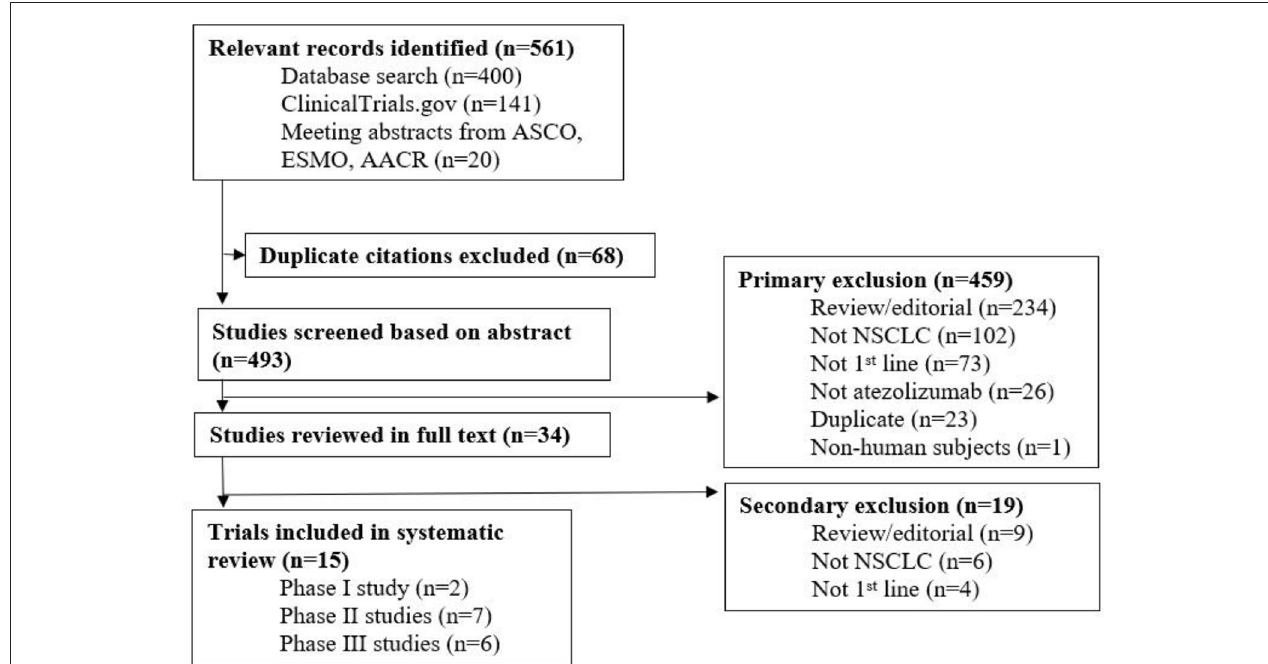
FIGURE 1 | Screening and eligibility evaluation